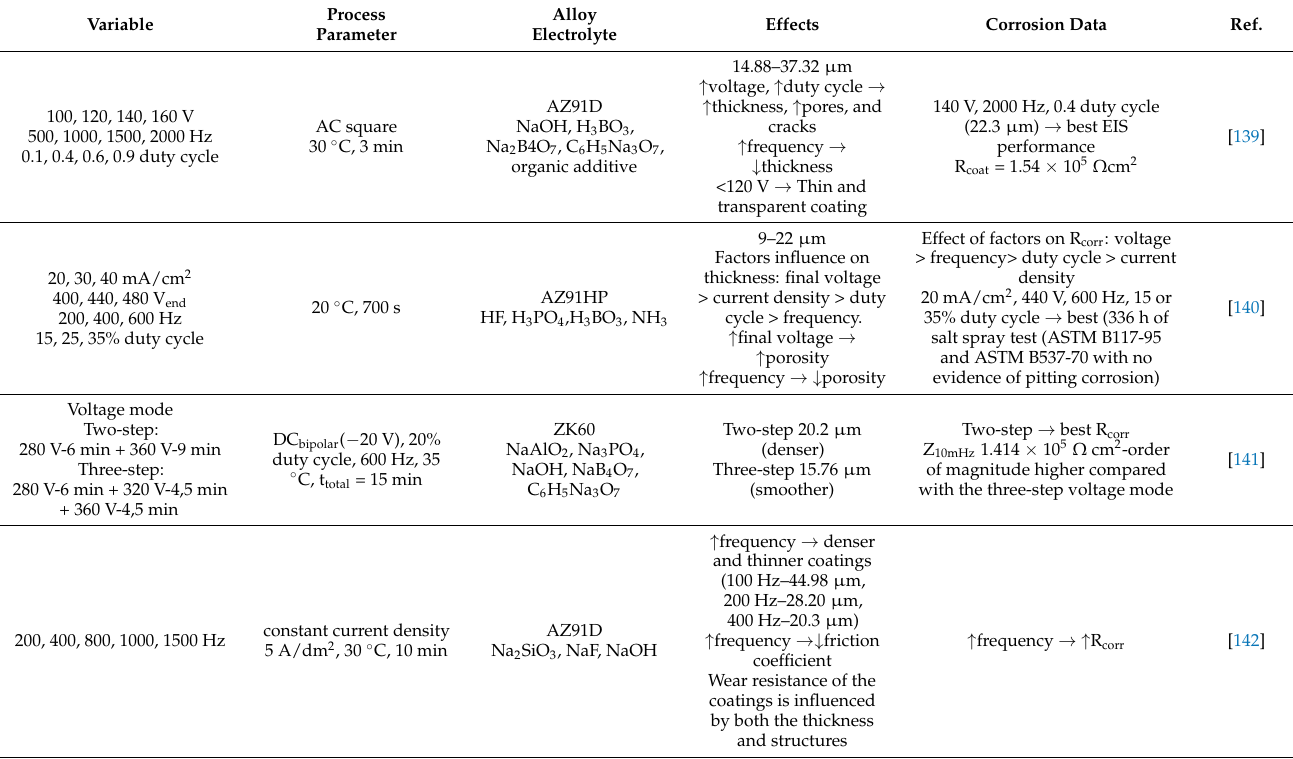
Table 3. Summary of energy input parameters during PEO of Mg alloys.